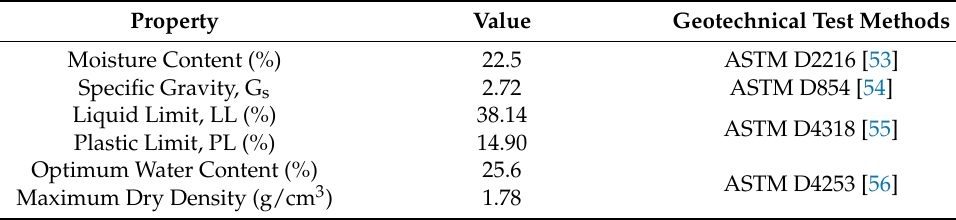
Table 1. The basic physical parameters of the CCC.